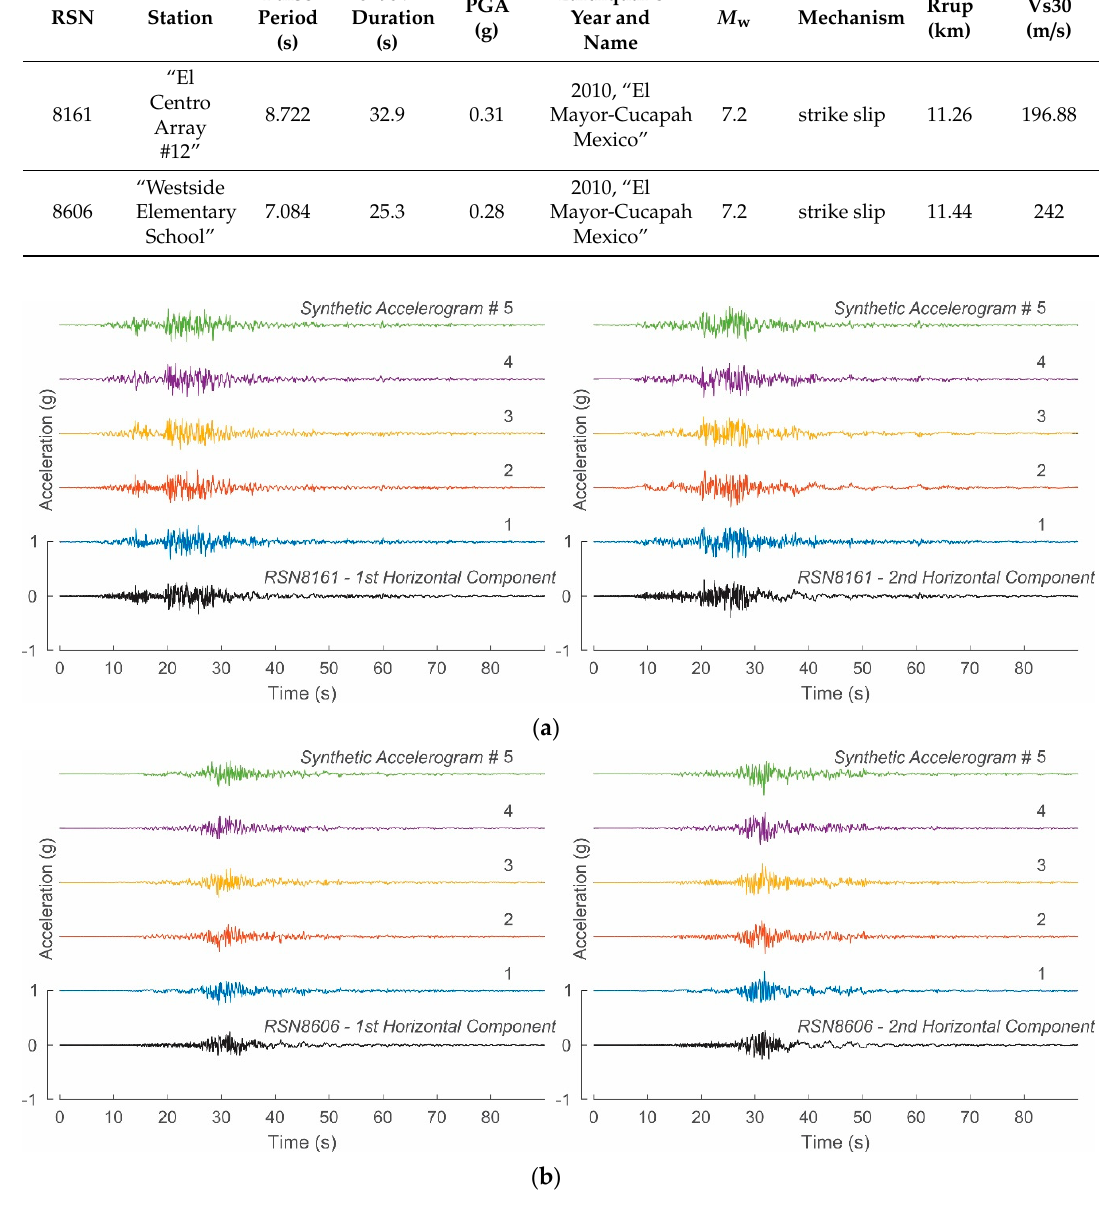
Figure 3. ( a ). Acceleration time histories of the two horizontal components of the real record